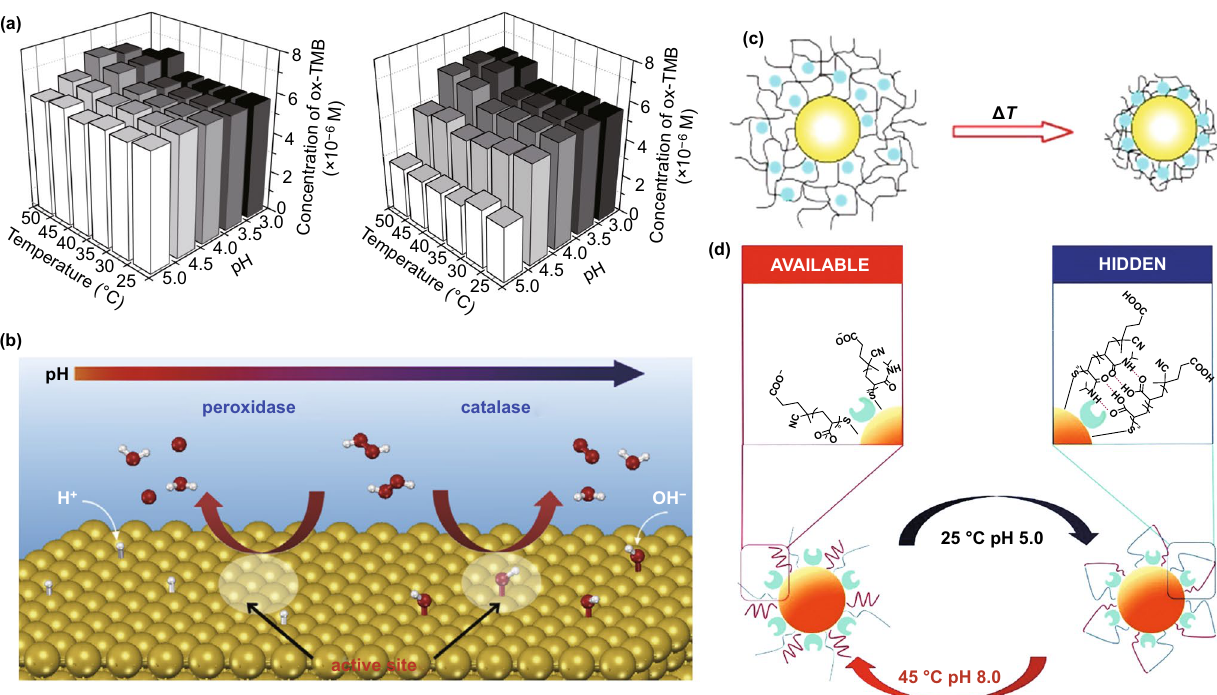
Fig. 4 pH and temperature dependence of different catalytic activities of AuNPs. a AuNPs coated with different concentrations of the same peptide (3 times higher on the left) will respond differently to temperature and pH changes as for their peroxidase‑like capability to oxidize TMB [107]. Copyright 2019 Lee et al. b pH switchability of AuNPs in terms of their catalytic activity, which shows different H 2 O 2 decomposition routes caused by the adsorption of OH groups to the gold surface in basic conditions [108]. Copyright 2015 Elsevier Ltd. c Thermosensitive polymeric layers used to stabilize AuNPs might undergo structural changes that block the catalytic active state of the nanomaterials [111]. Copy‑ right 2006 Wiley–VCH Verlag GmbH & Co. KgaA. d “On/off” nanozyme controlled by means of a temperature and pH change that result in the formation of a cage‑like structure by hydrogen bonding between polymer chains in the surface of the AuNP [112]. Copyright 2019 The Royal Society of